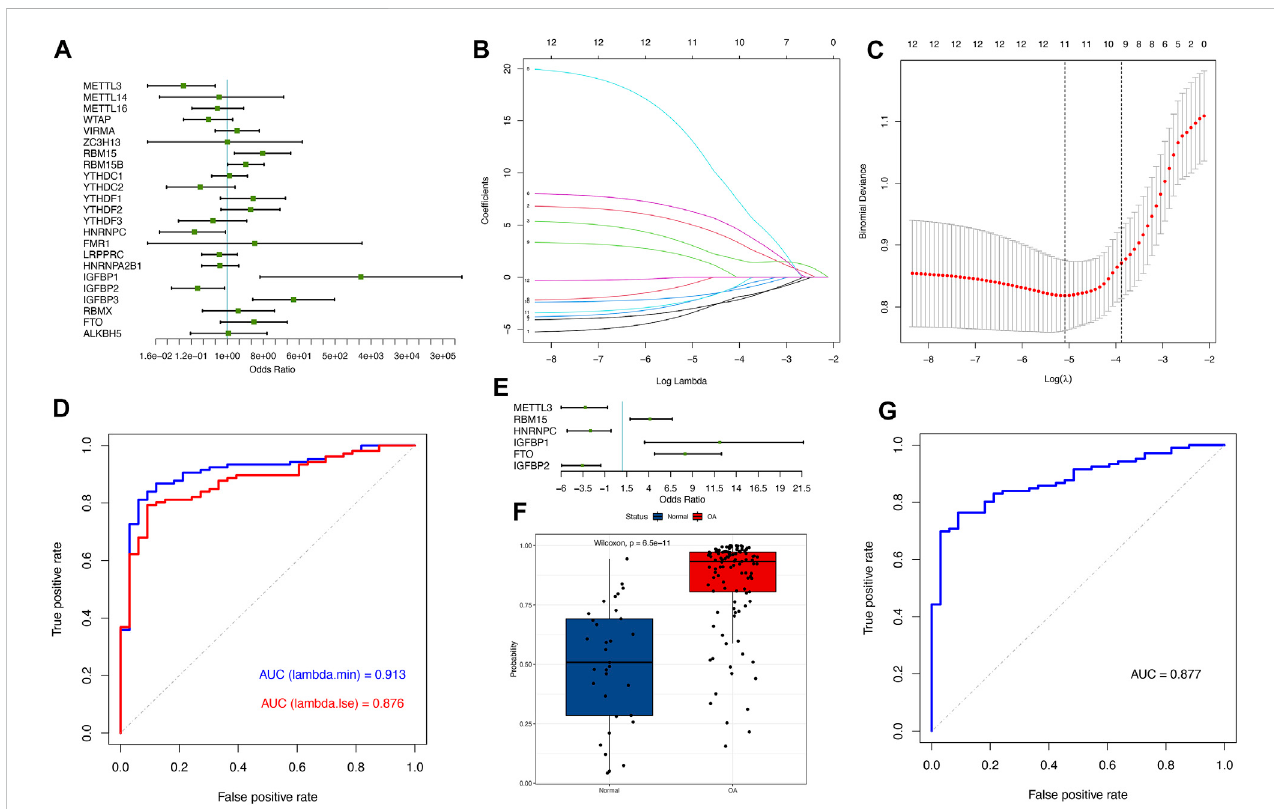
FIGURE 2 m 6 Aregulatorshaveprofoundeffectsontheosteoarthritisprocess. (A) Univariatelogisticregressionpresentingtherelationshipbetweenm 6 Aregulators andosteoarthritisrevealed 12OA-relatedm 6 Aregulators ( p < 0.2). (B) LASSOcoef fi cientdistributionof12OA-associatedm 6 Aregulators. (C) Cross-validation for tuning parameter selection in the LASSO regression. For each λ value, around the mean of the target parameter shown by the red dot, we obtained the con fi denceintervalofonetargetparameter.Twodashedlinesindicatetwospecial λ values:lambda.minwasreferredtoinall λ values,theonegivingthe minimumtargetparametricmean,andlambda.1sereferstotheonethatgavethesimplestmodelwithavarianceinthelambda.min λ value. (D) TheROCcurve illustrated that the LASSO model, which includes 12 m 6 A regulators according to MSE, has better performance in distinguishing between normal and osteoarthritis samples than 1-SE, with an AUC value of 0.913. (E) Multivariate logistic regression presenting the relationship between m 6 A regulators and osteoarthritis revealed 6 osteoarthritis-related m 6 A regulators ( p < 0.05). (F) Boxplot showing the probability difference between normal and osteoarthritis samples, where osteoarthritis had a much higher probability score than normal samples. (G) The ROC curve depicting that the classi fi cation model based on 6 m 6 A regulators has good prediction